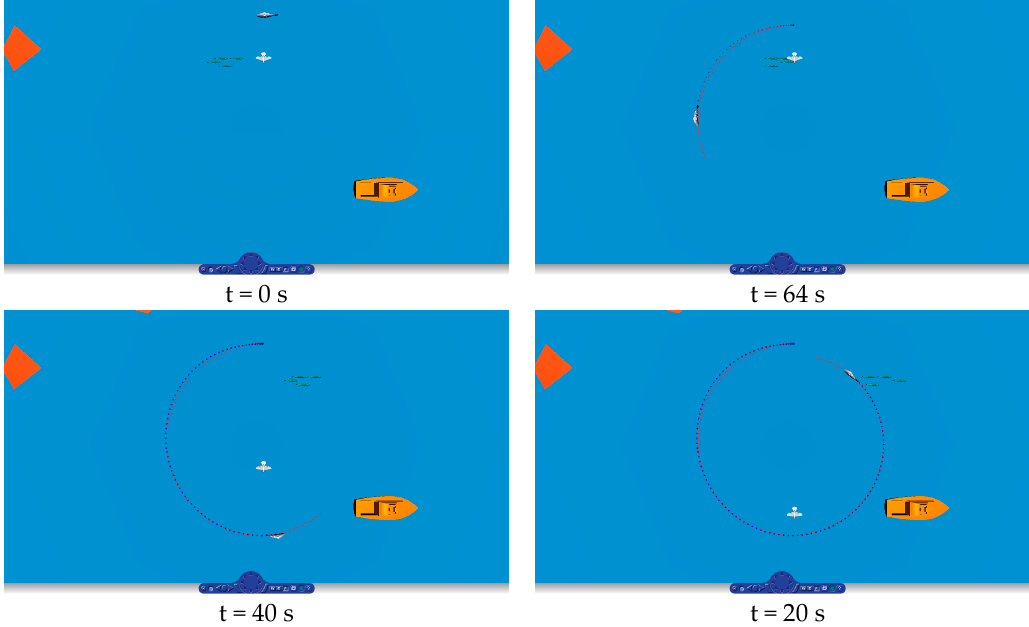
Figure 25. Top view above the sea for closed loop P 2 tracking simulation.